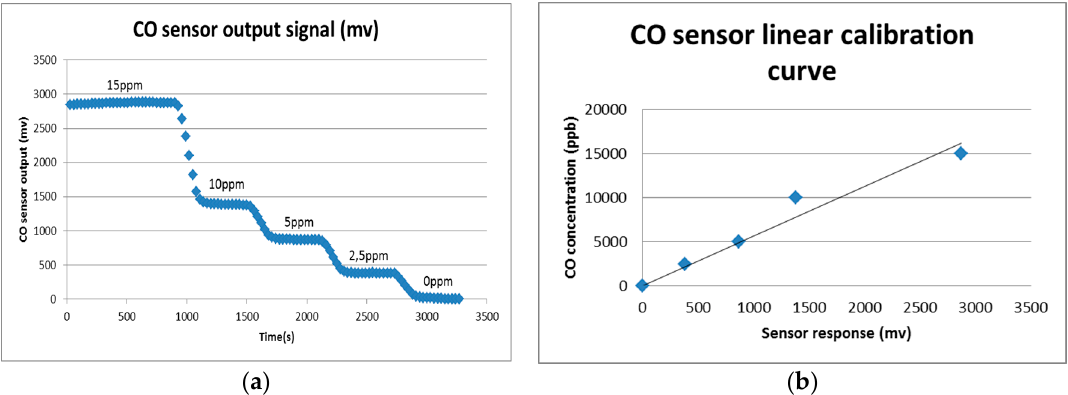
Figure 3. ( a ) CO sensor response during in lab univariate calibration recordings and the corresponding linear calibration curve.